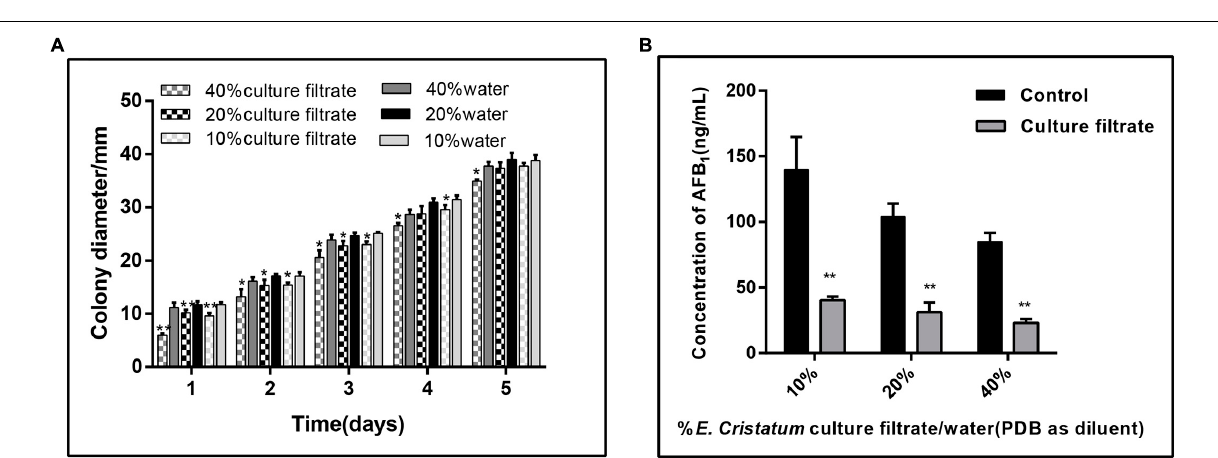
FIGURE 2 | Effects of the E. cristatum culture filtrate on growth and AFB 1 production of A. flavus . (A) The colony diameter of A. flavus in PDA medium with 10, 20, and 40% E. cristatum culture filtrate or water at 28 ± 2 ◦ C for the first 5 days. (B) AFB 1 content in PDA medium with different concentrations of E. cristatum culture filtrate and water at 28 ± 2 ◦ C for 5 days. Values in each column followed by one ( p < 0.05) or two ( p < 0.01) asterisks are significantly different from the control according to the Student’s t